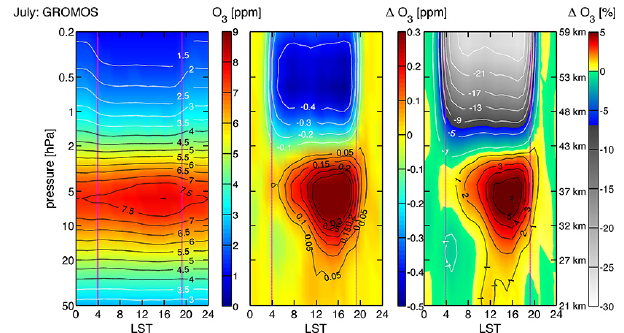
Figure 4c. Same as Fig. 4a but for the month of July.